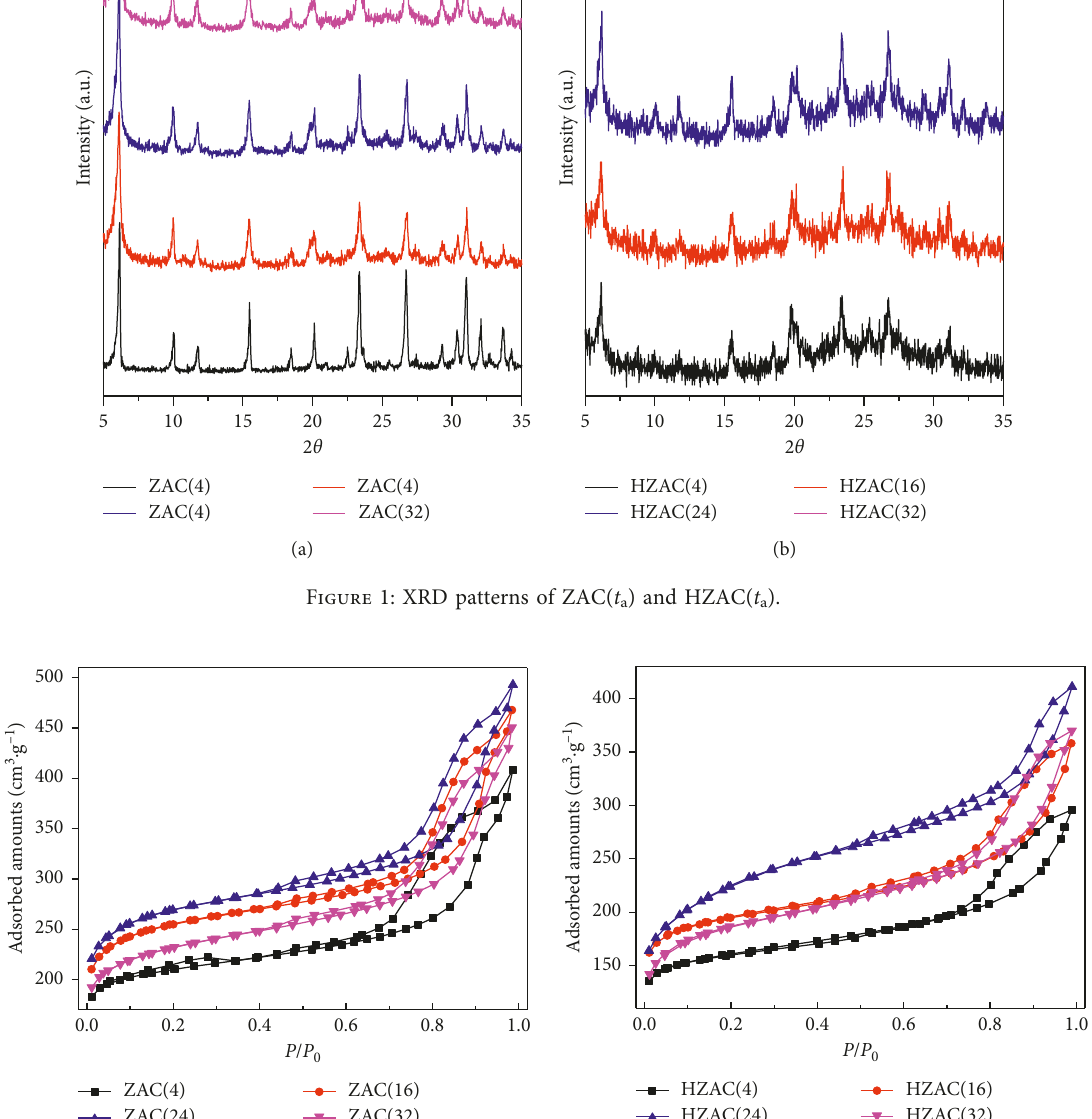
Figure 2: N 2 adsorption-desorption isotherms at 77K of ZAC( t a ) and HZAC( t a